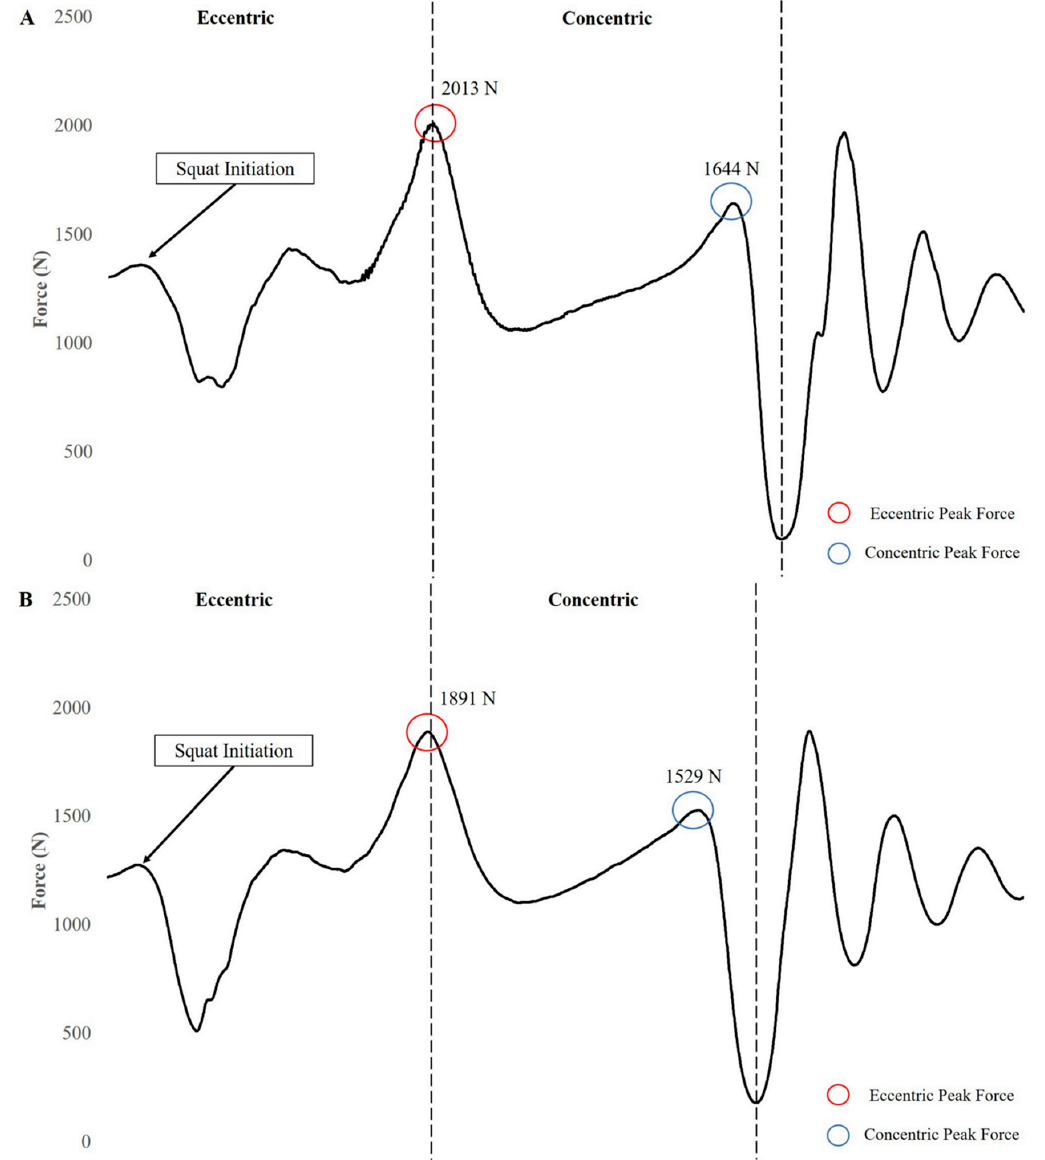
Figure 4. Force–time curves of an accentuated eccentric loaded ( A ) (65 kg + 20 kg on weight releasers) and traditional ( B ) (65 kg) back squat performed by a healthy, 29 year old female.